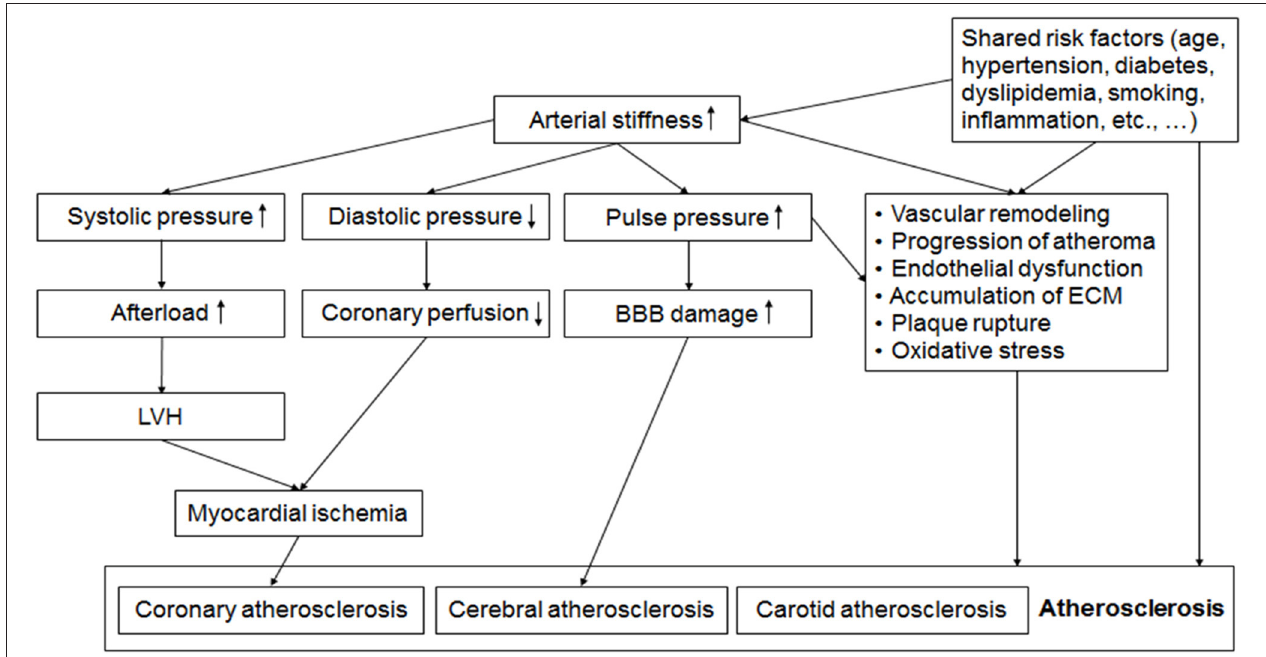
FIGURE 1 | Possible mechanisms linking arterial stiffness and atherosclerosis. Alteration of pulsatile hemodynamics by increased arterial stiffness is associated with left ventricular hypertrophy (LVH), reduced coronary perfusion and the damage of blood brain barrier (BBB), which leads to coronary and cerebral atherosclerosis. Endothelial dysfunction, oxidative stress, vascular remodeling, accumulation of extracellular matrix (ECM), and shared common risk factors such as aging, hypertension, diabetes, and dyslipidemia are also factors linking increased arterial stiffness and the development and progression of atherosclerosis. BBB, blood brain barrier; ECM, extracellular matrix; LVH, left ventricular